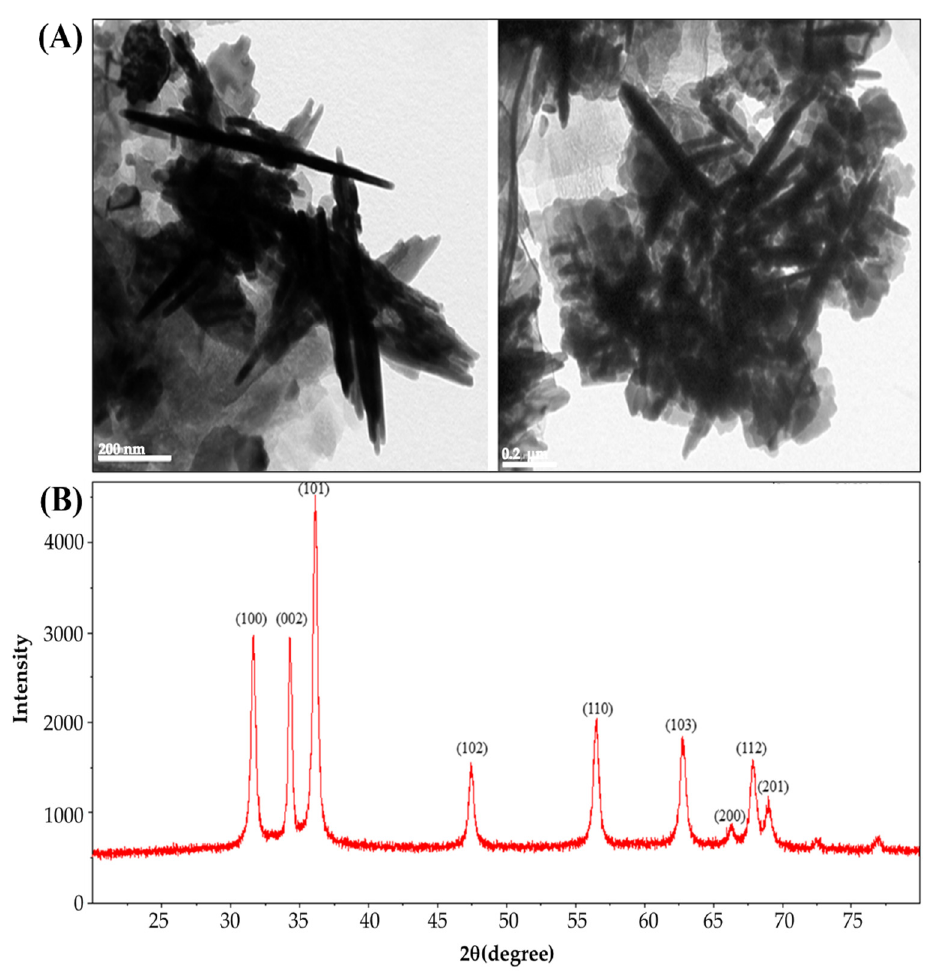
Figure 1. TEM ( A ) and XRD patterns, ( B ) of ZnONPs synthesized from Asiatic pennywort ( Centella asiatica L.) extract.